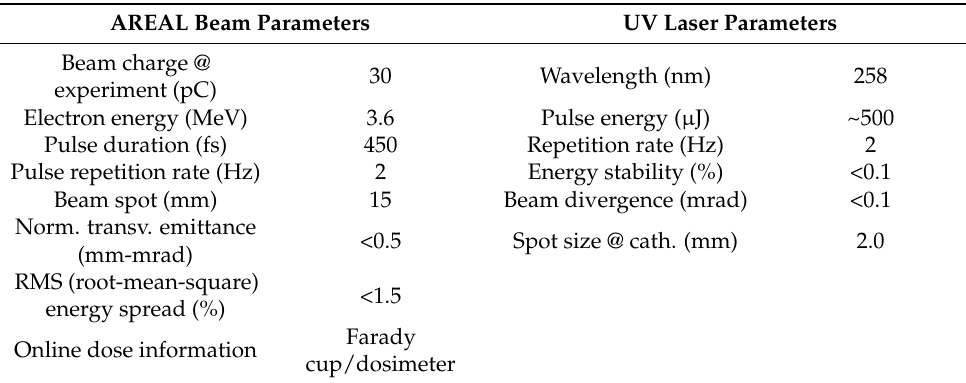
Table 1. Characteristics of the AREAL laser-generated electron